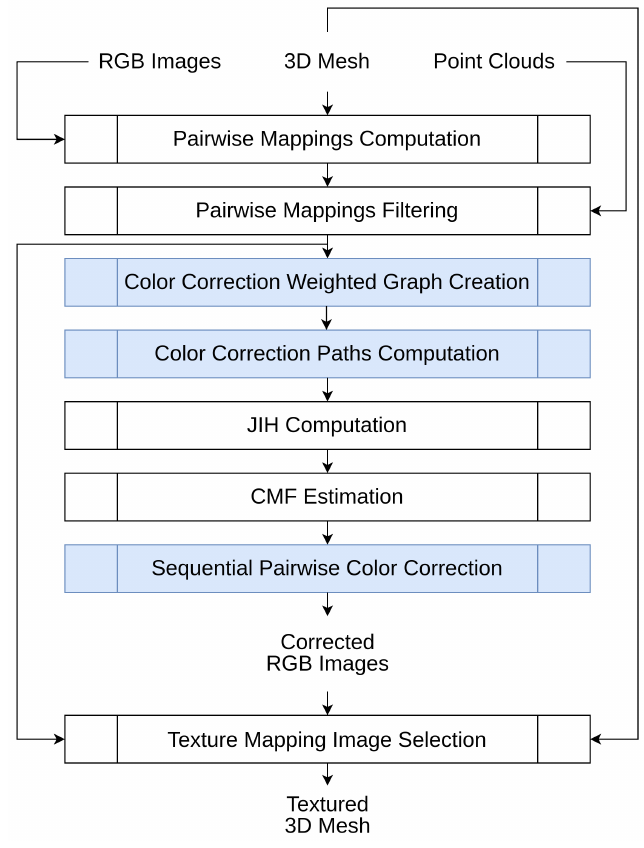
Figure 1. Architecture of the proposed approach. As input, our system receives RGB images, a 3D mesh, and point clouds from different scans, all geometrically registered to each other. In the first part, seven steps are performed to produce the corrected RGB images. Subsequently, we execute one last step to produce the textured 3D mesh. The core contributions of this paper are highlighted in blue. The non-squared elements represent data. The squared elements represent